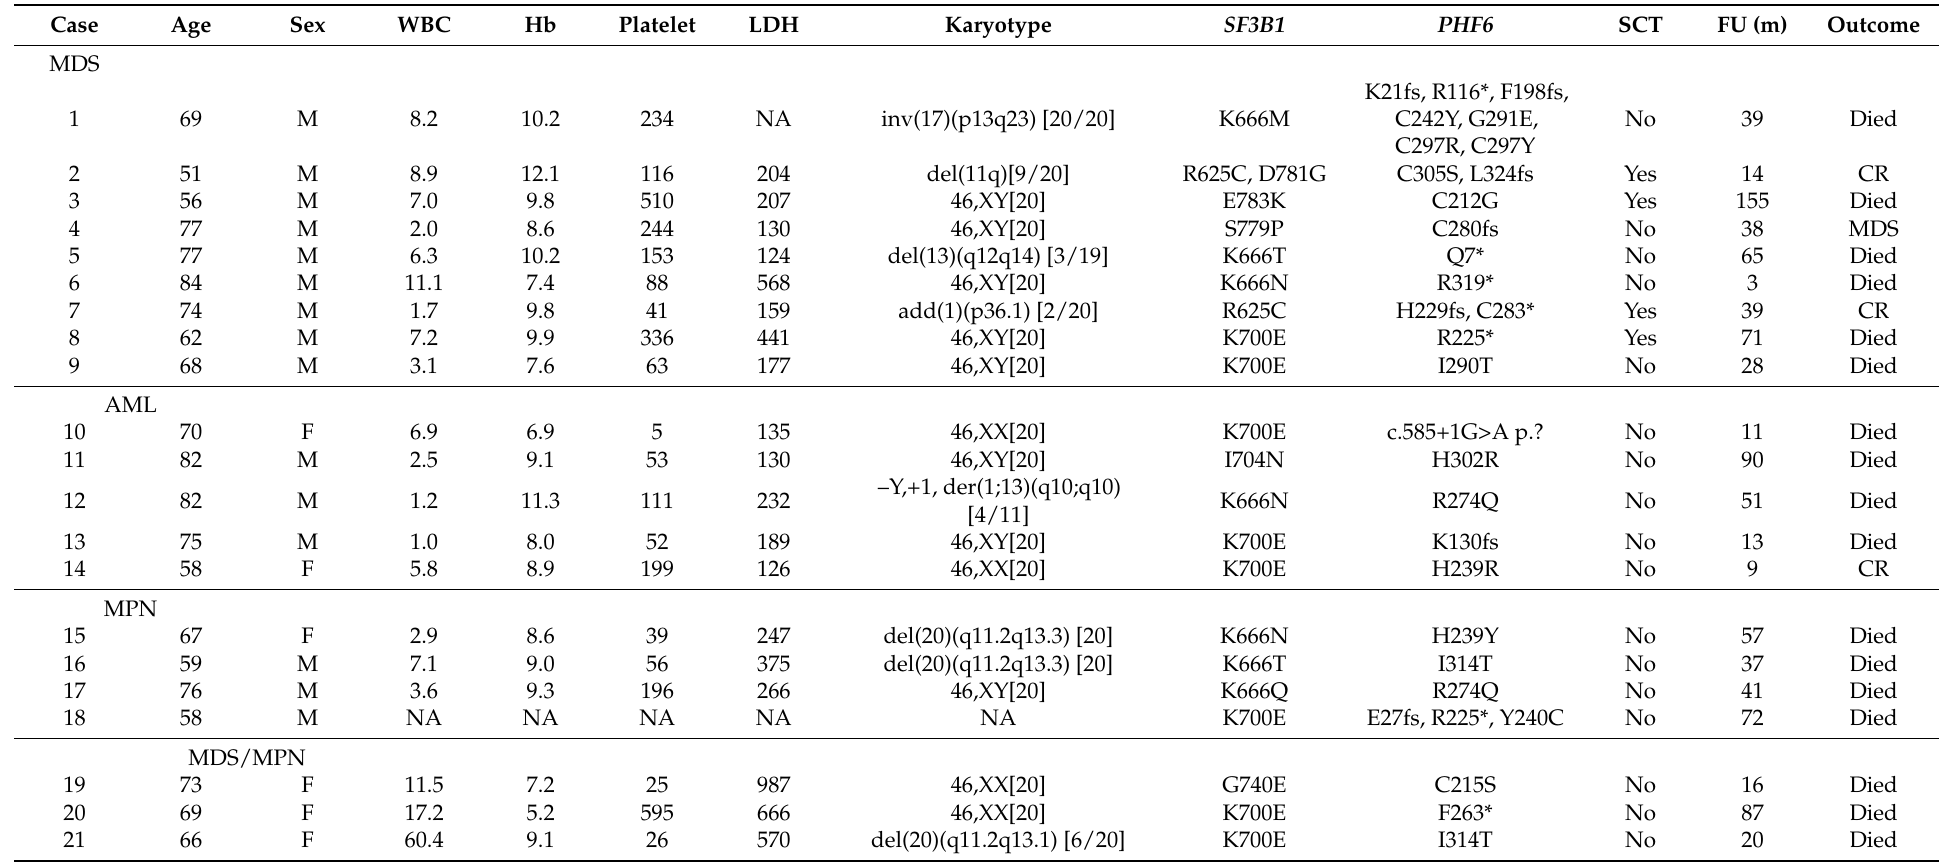
Table 1. Clinicopathologic and molecular genetic features of 21 patients with myeloid neoplasms with SF3B1 and PHF6